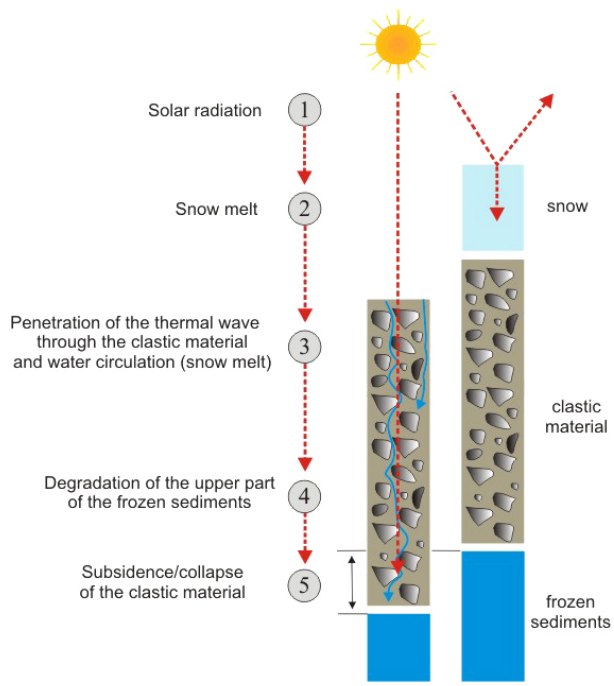
Figure 8. Interpretative diagram of the knock-on physical pro-